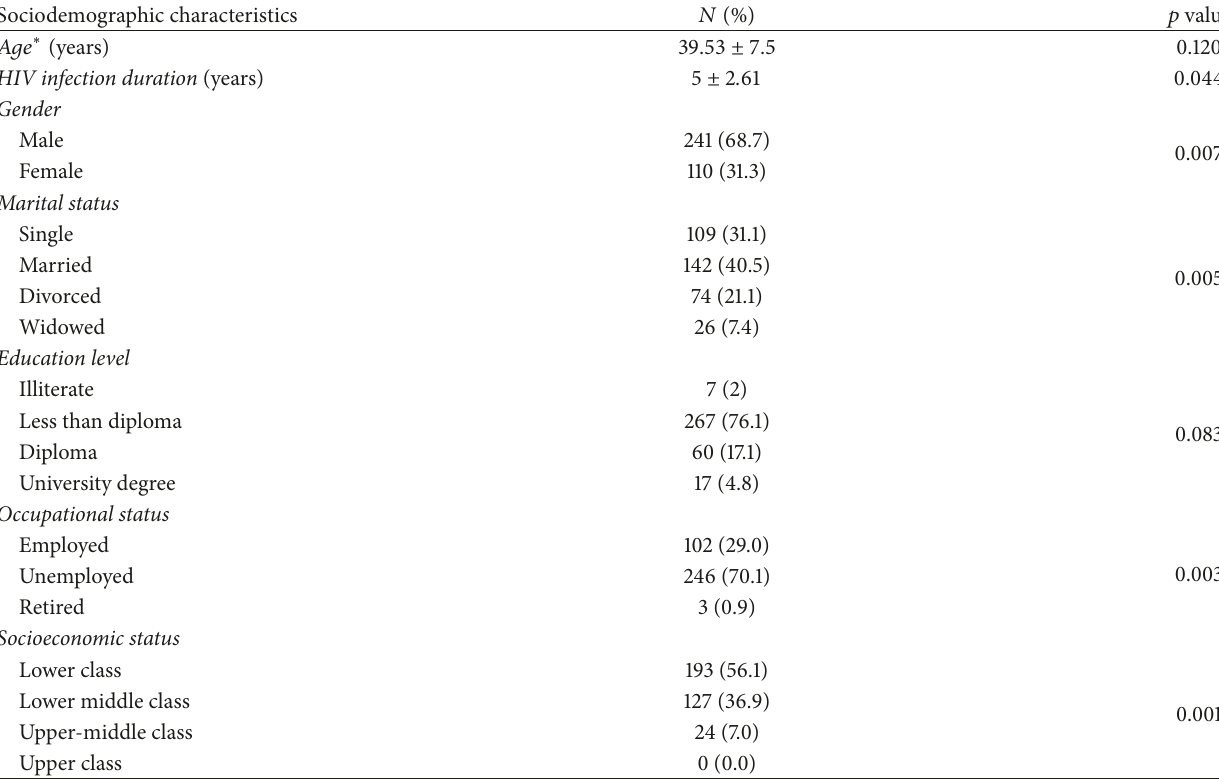
Table 1: Demographic characteristics of the